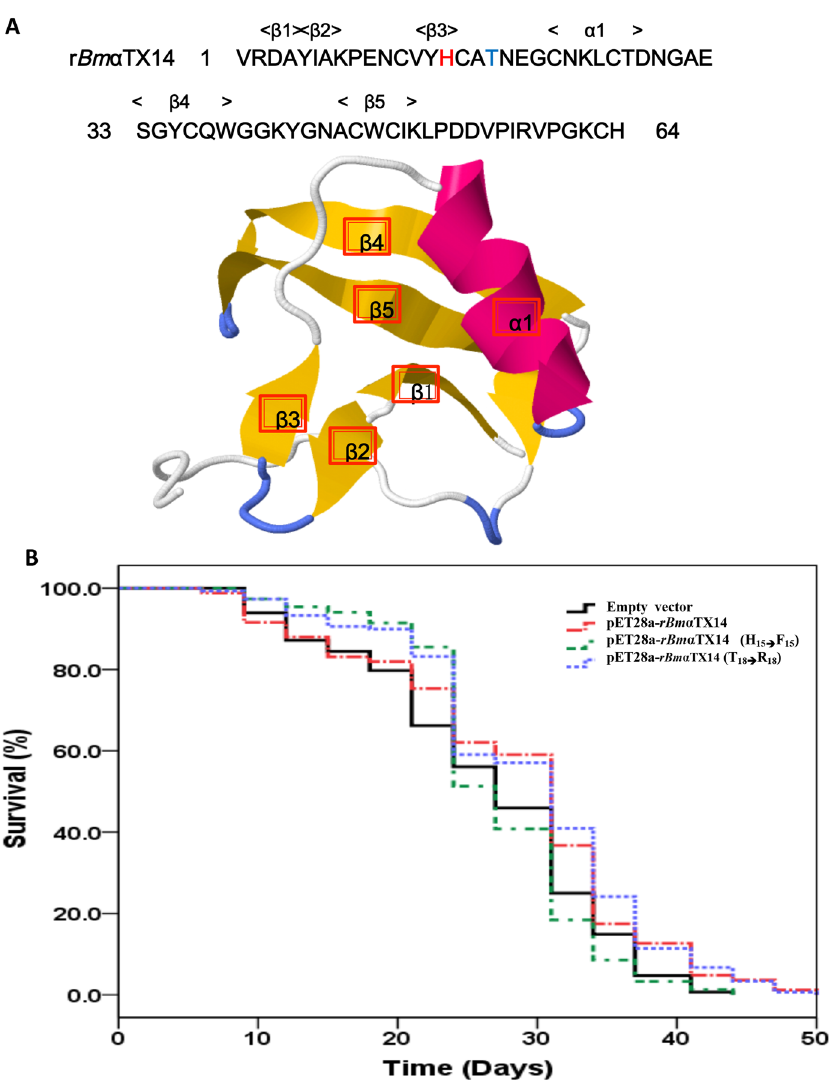
Fig 4. r Bm α TX14 mutations affect the extension of C . elegans life span. (A) The rBm α TX14 protein sequences were mutant at H 15 or T 18 . The structure model predicted that H 15 play an important role in β 3. (B) Amino acid change from H 15 to F 15 in r Bm α TX14 altered the life span of C . elegans . The life span assays were performed as above, and the nematodes were treated with different mutant strains in 96-well